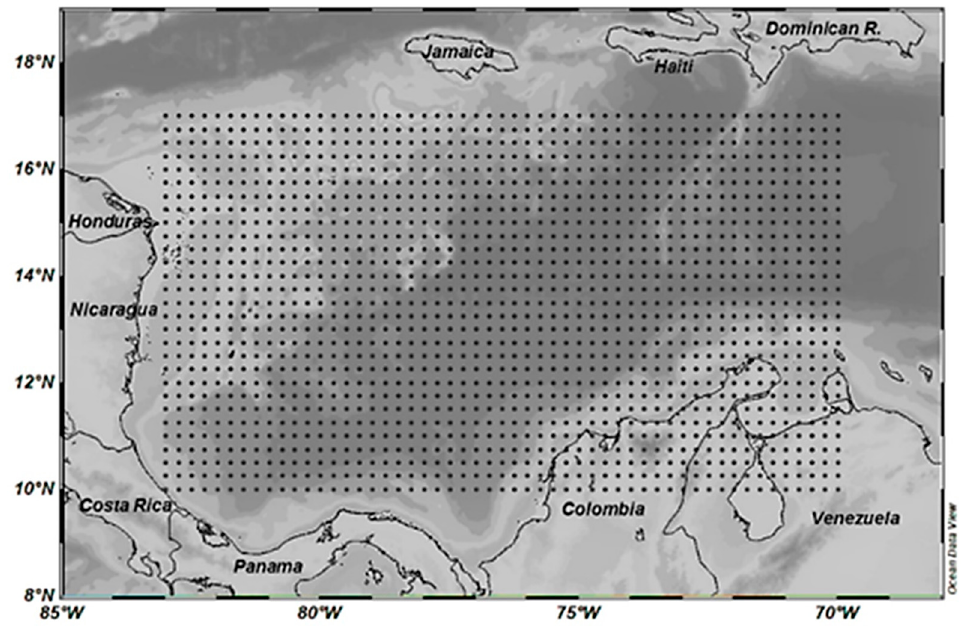
Figure 2. Study area and spatial coverage of the analyzed Reanalysis data (gray dots).